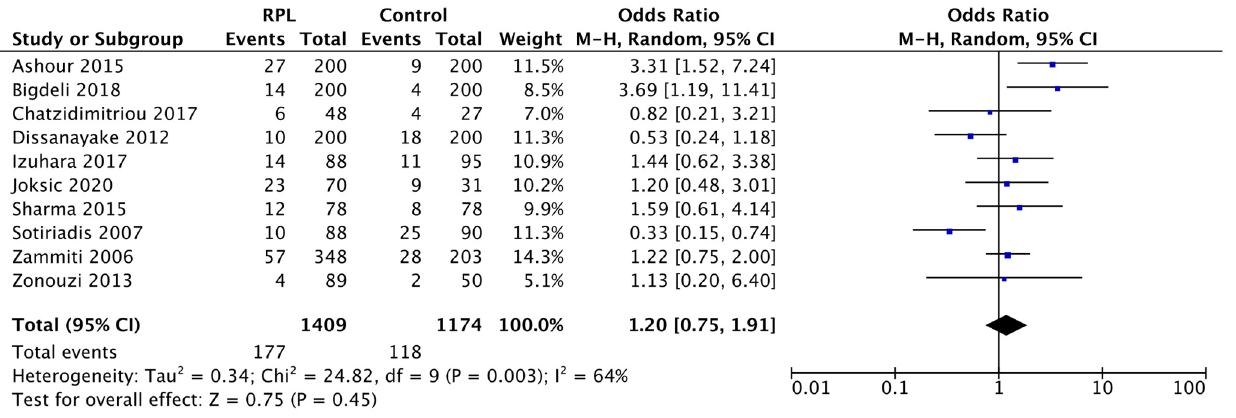
Figure 7. Sensitivity analysis of the H1299R and RPL by excluding NOS low score studies. The forest plot illustrates the horizontal black lines representing the 95% CIs and the weight of each study as a blue square. The black diamond represents the estimate of the overall effect. I 2 is an index of heterogeneity. In the sensitivity analysis, the number of events indicates the presence of the H1299R variant without distinction between Het and Hom. Overall effect OR: 1.20 [0.75, 1.91]; p = 0.45.